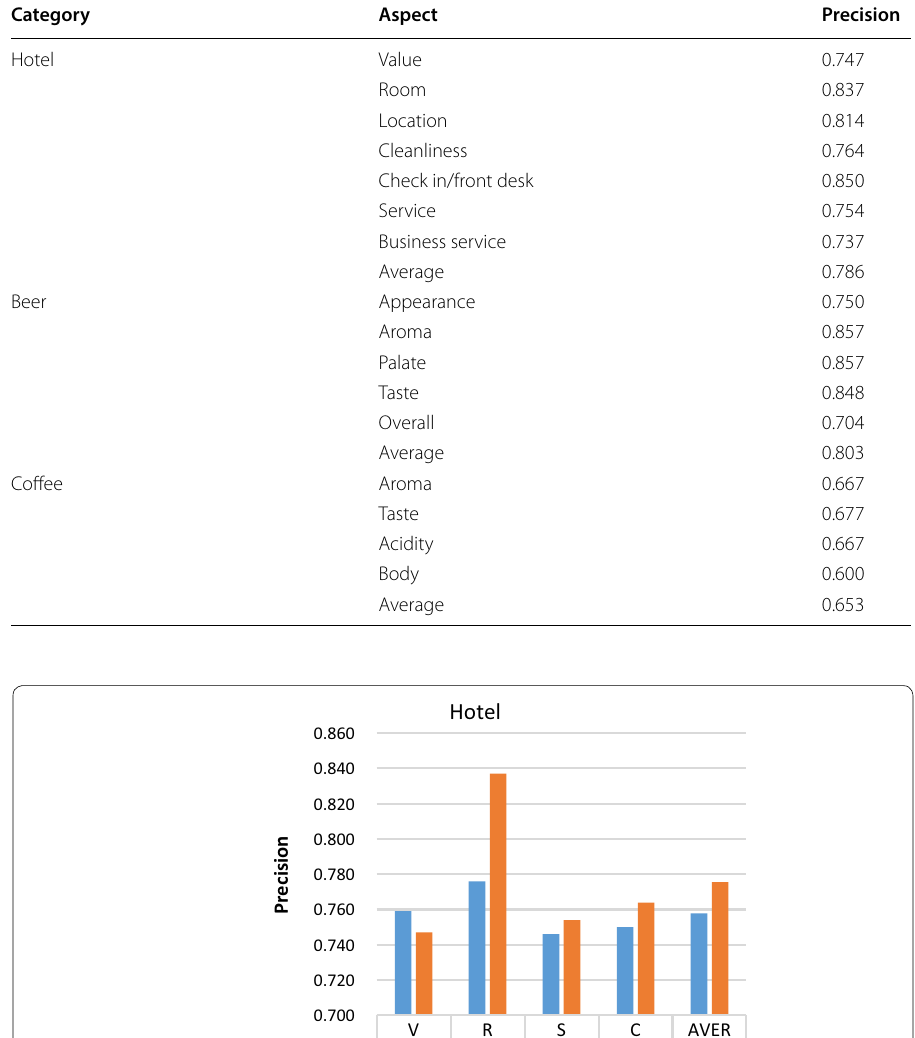
Table 5 Aspect Identification results